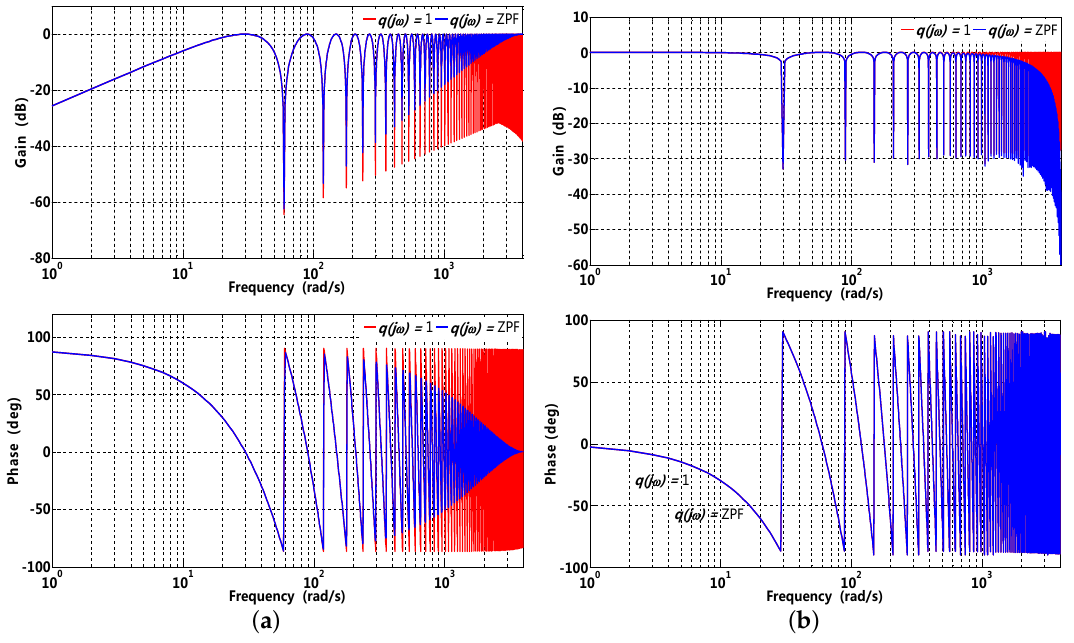
Figure 6. Frequency characteristics with respect to the low-pass filter (LPF): ( a ) 1 − Q ( z − 1 ) z − m ; ( b ) Q ( z − 1 )